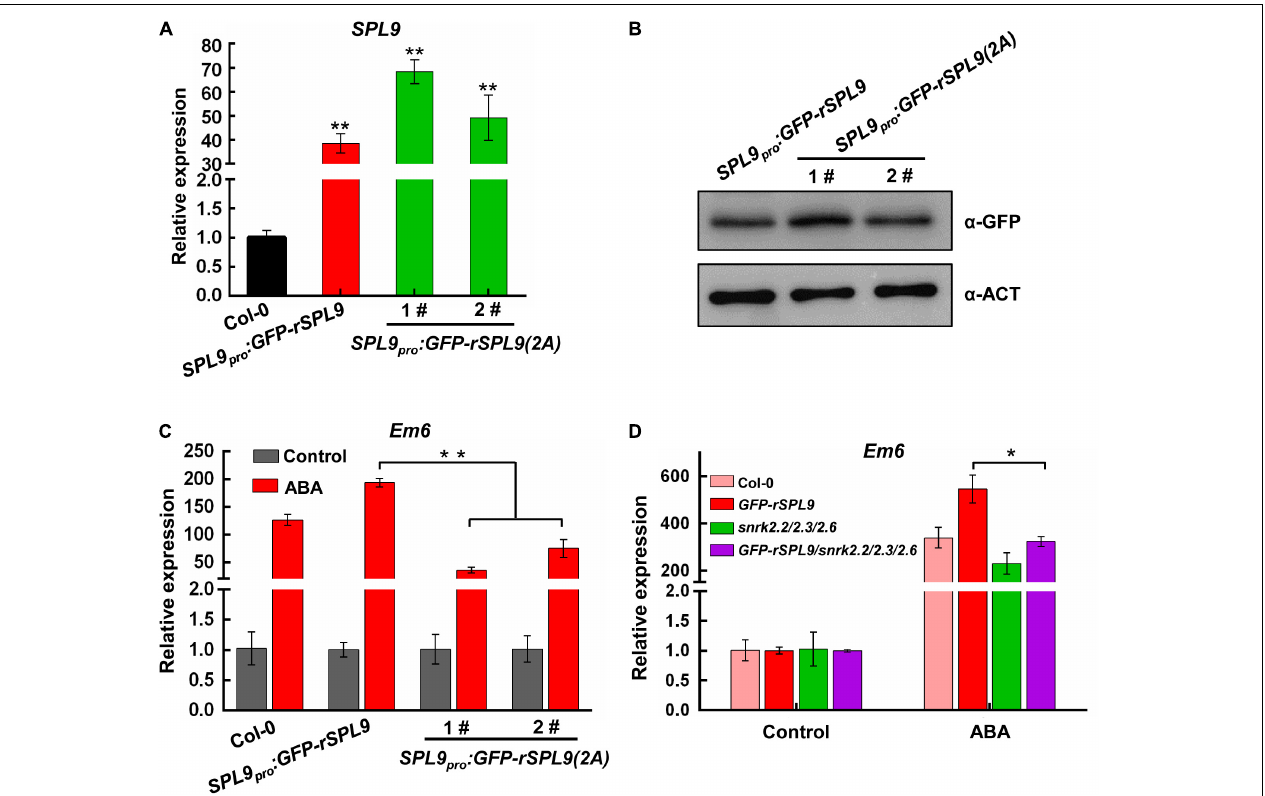
FIGURE 6 | The phosphorylation by SnRK2s is required for SPL9 in enhancing ABA responses. (A) qRT-PCR assays showing the expression levels of SPL9 in the indicated seedlings. Values are means ± SD ( n = 3). ** P < 0.01 by the Student’s t -test. (B) Immunoblotting assays showing the protein levels of SPL9 in the indicated seedlings. Anti-GFP antibody was used. Actin was used as a loading control. (C) qRT-PCR assays showing that phosphorylation of SPL9 by SnRK2s is required for the activation of Em6 expression. The 6-day-old seedlings were treated without or with 50 µ M ABA for 4 h. The expression levels of Em6 in control samples were set to 1 for each genotype. Data are means ± SD ( n = 3). ** P < 0.01 (Student’s t -test). (D) qRT-PCR assays showing that the SPL9-mediated ABA induction of Em6 is dependent on SnRK2s. The 4-day-old seedlings were treated without or with 10 µ M ABA for 4 h. The expression levels of Em6 in control samples were set to one for each genotype. Data are means ± SD ( n = 3). ** P < 0.01 (Student’s t -test).